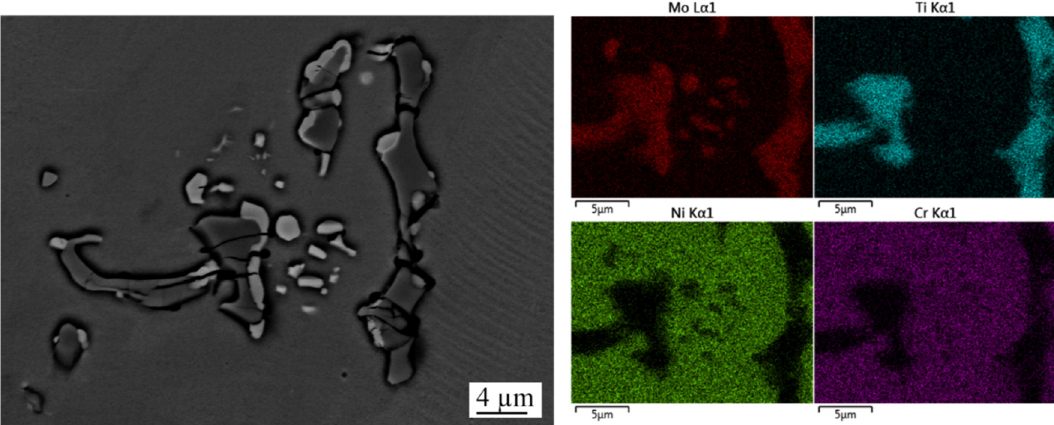
Figure 4. Volume fraction of secondary phases, hardness, and grain size values for the different conditions.